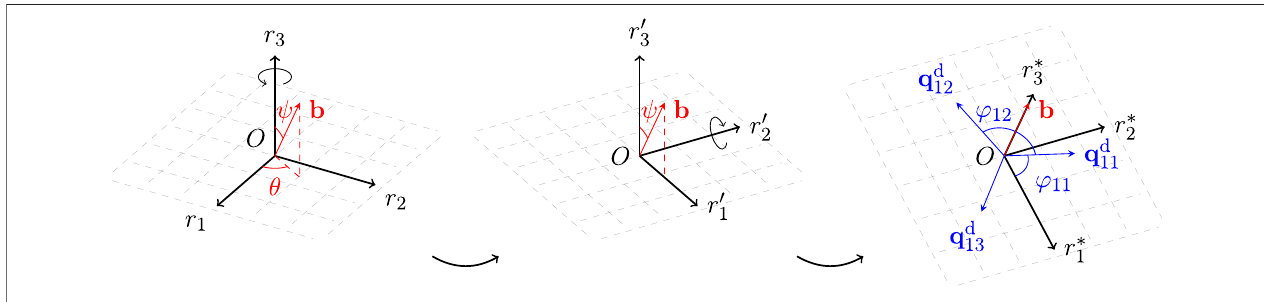
FIGURE 1 | Rotations of coordinates system. θ and ψ are the azimuthal and polar angles of the magnetic fi eld b , respectively. φ 11 is the angle between the wave vector q d 11 and the axis r * 1 , and φ 12 is the angle between the wave vector q d 11 and q d 12 [see Eqs. (4 , 5)